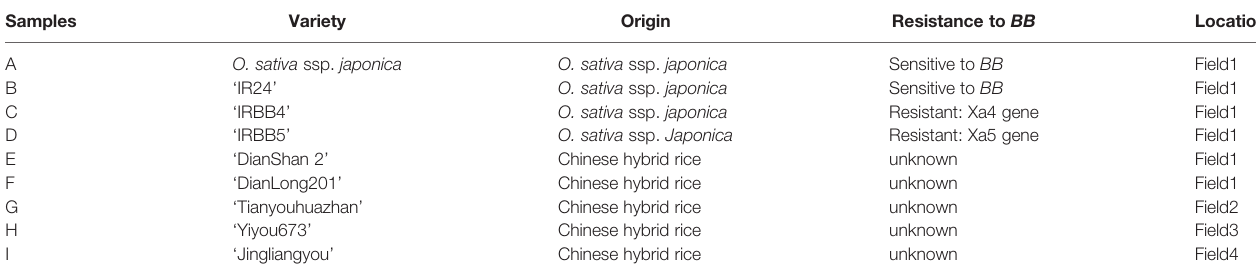
TABLE 1 | Rice cultivars used in this study.